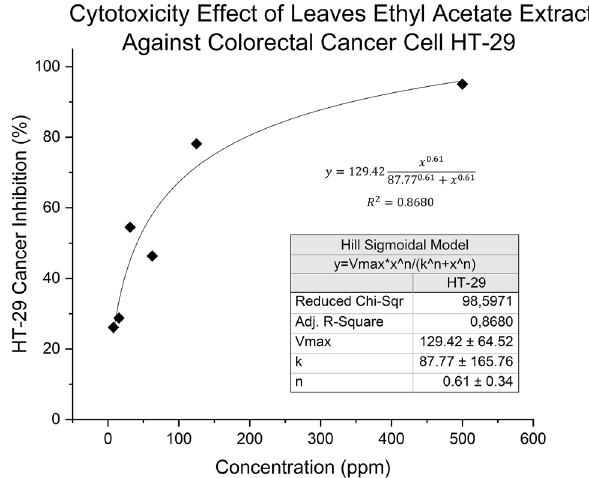
Figure 6. Cytotoxicity effect of X. granatum against of HT-29.